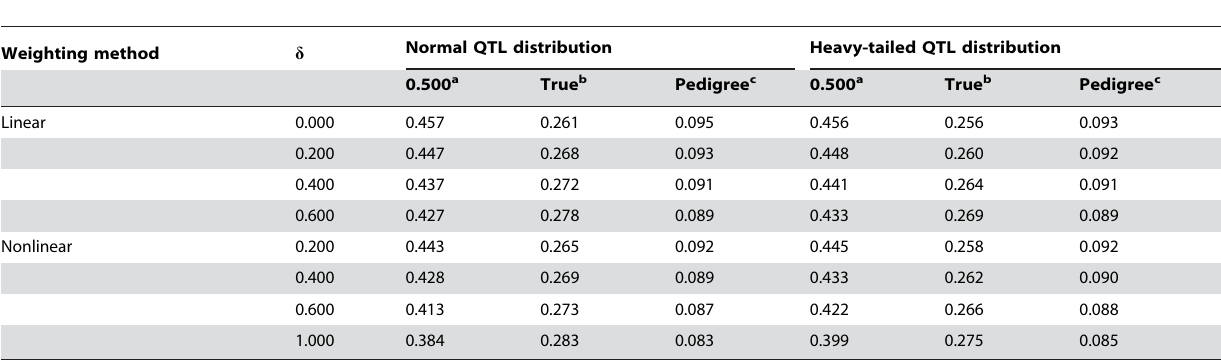
Table 2. Mean inbreeding coefficients in the final generation calculated using different allele frequencies for simulated populations using 2 QTL distributions.